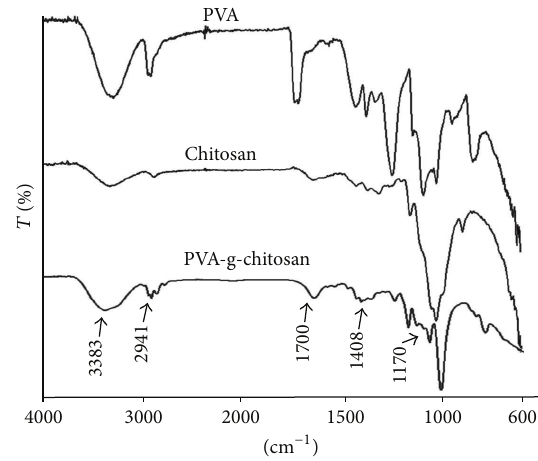
Figure 1: FT-IR spectrum of PVA, chitosan, and PVA-g-chitosan 3D